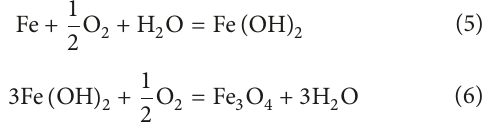
Moreover, the values of corrosion rate ( 𝑅 Corr ) were obtained as follows